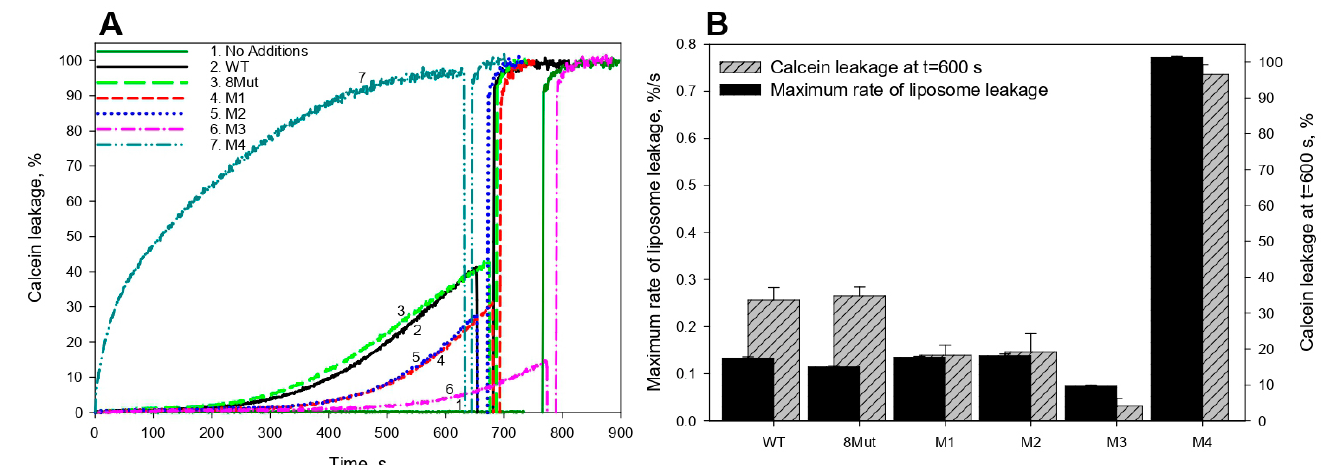
Figure 2. ( A ) Time courses of calcein leakage from liposomes induced by the addition of WT CytC or its mutants with H 2 O 2 and ( B ) maximum rates of the liposome leakage measured after the addition of the mutant proteins (8Mut-K8E/K27E/K72E/K86E/K87E/E62K/E69K/E90K, M1- T78N/K79Y/M80I/I81M/F82N, M2-T78S/K79P, M3-I81Y/A83Y/G84N, M4-P76I/G77L/I81L/F82L). Results are expressed as mean ± SE of at least three experiments. At the end of each leakage trace, 0.1% Triton X-100 was added, and the level of calcein fluorescence recorded after the addition of Triton X-100 was used as 100% leakage.